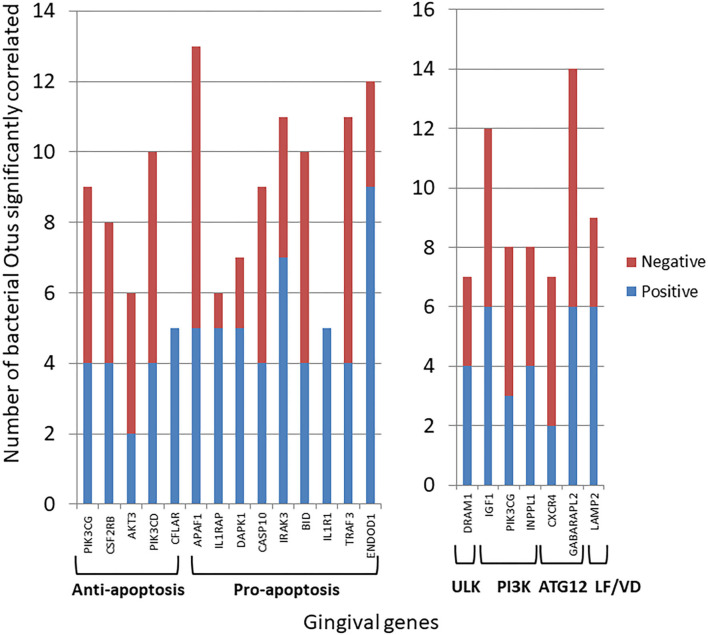
Individual gene expression levels correlated with bacterial abundance levels in the microbiome samples. The stacked bars depict the frequency of microbial correlations of a particular apoptotic or autophagy gene separated into significant (p < 0.05) positive or negative correlations. Each gene is organized into apoptosis processes or steps in the autophagy pathway. The genes presented had > 7 total bacterial correlations except for CFLAR and IL1R1 that showed a unique pattern of only positive correlations.